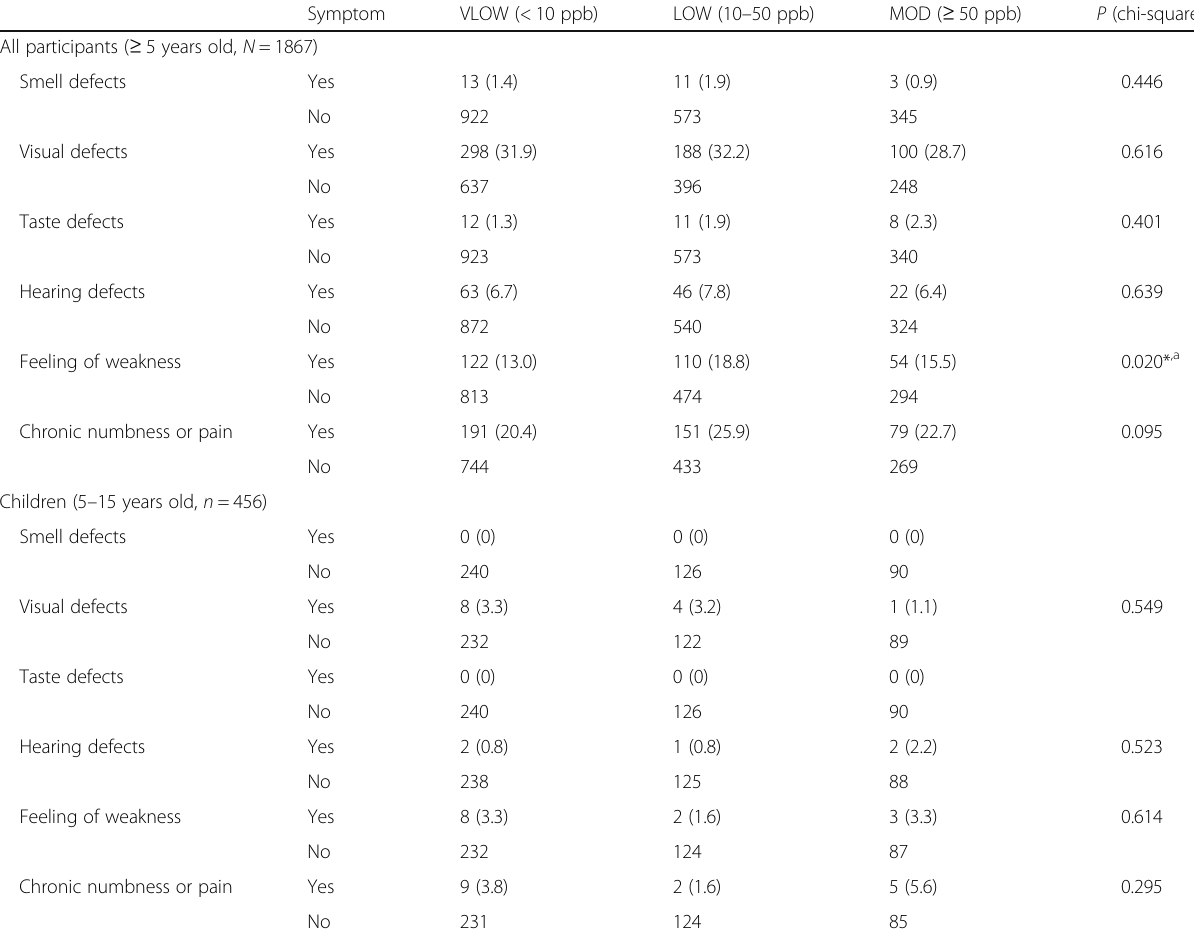
Table 1 Subjective neurological symptoms and arsenic concentration in drinking water (ACDW) Symptom All participants ( ≥ 5 years old, N =